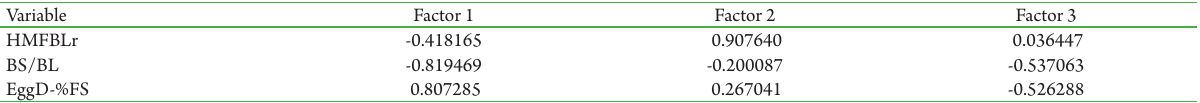
Table 6. Factor-variable correlation obtained from the PCA using the reproductive parameters as variables and 39 amphipod species listed in supplementary material, from which the three parameters were obtained.